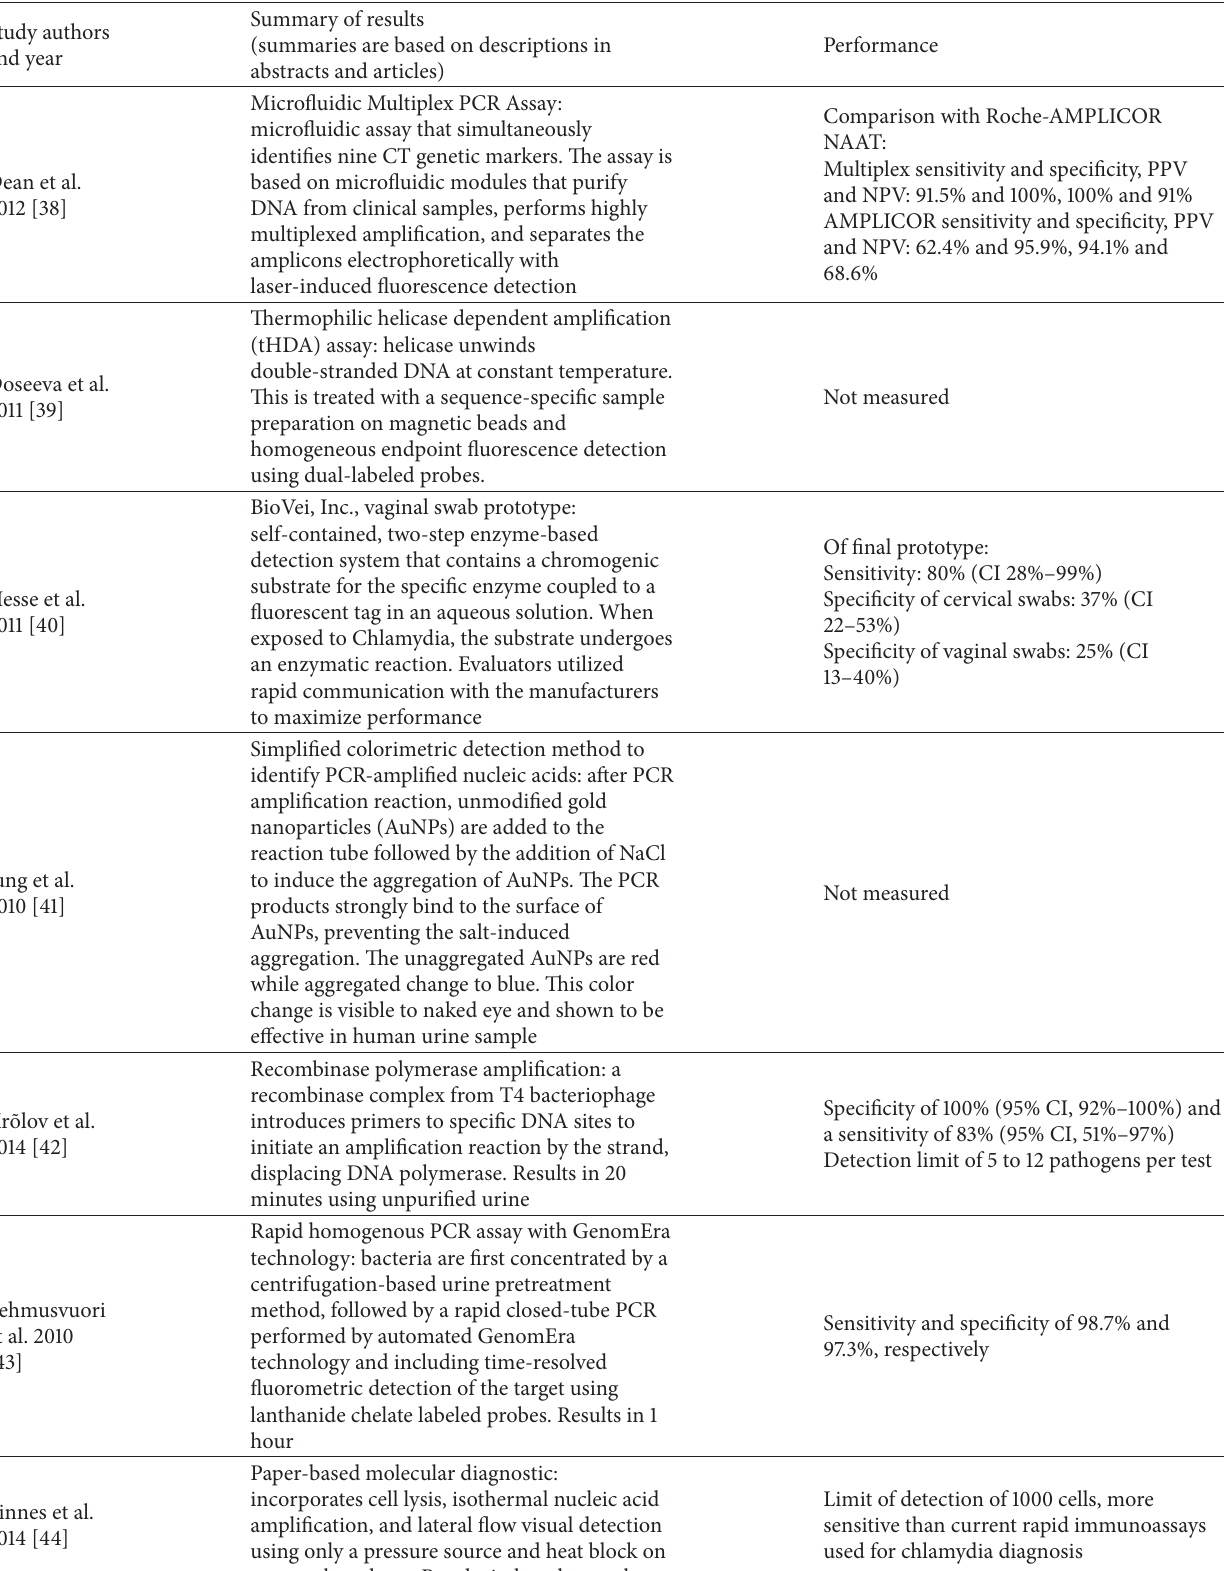
Table 4: Summary of proof of concept articles on point of care tests for Chlamydia trachomatis from 2010 to